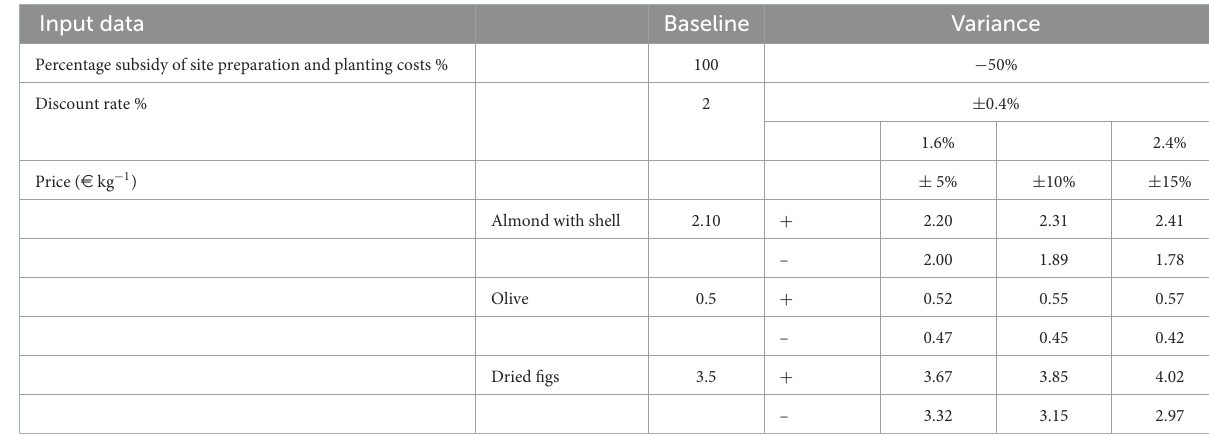
TABLE 4 Input data for sensitivity